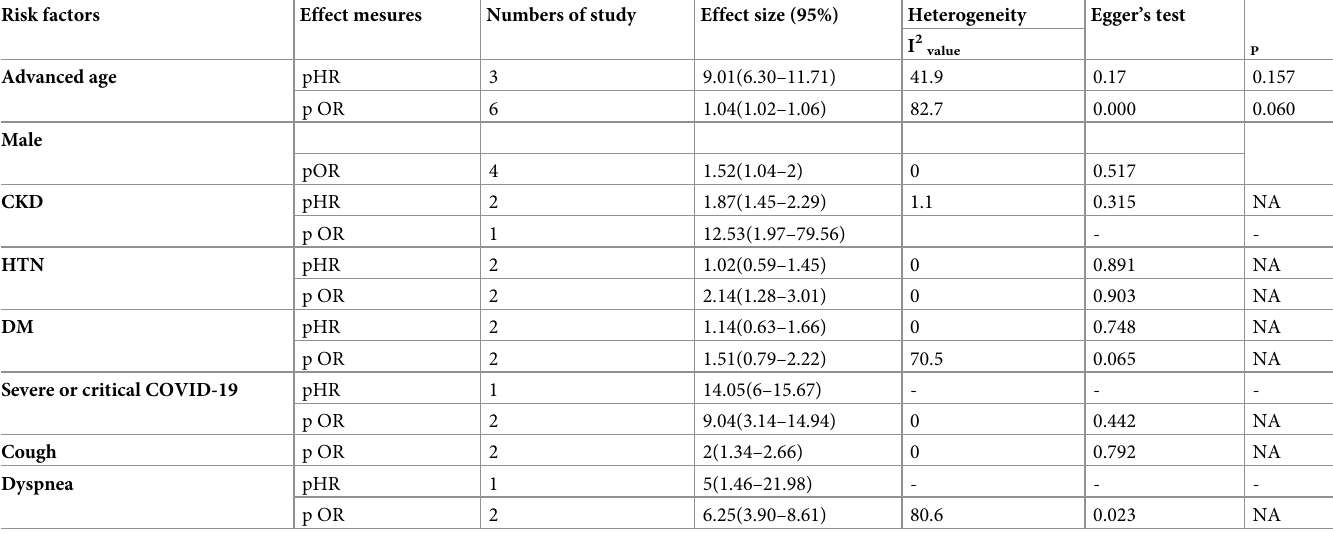
Table 3. Results of subgroup analysis based on demographic, clinical, and comorbidities variables associated with coronavirus mortality.